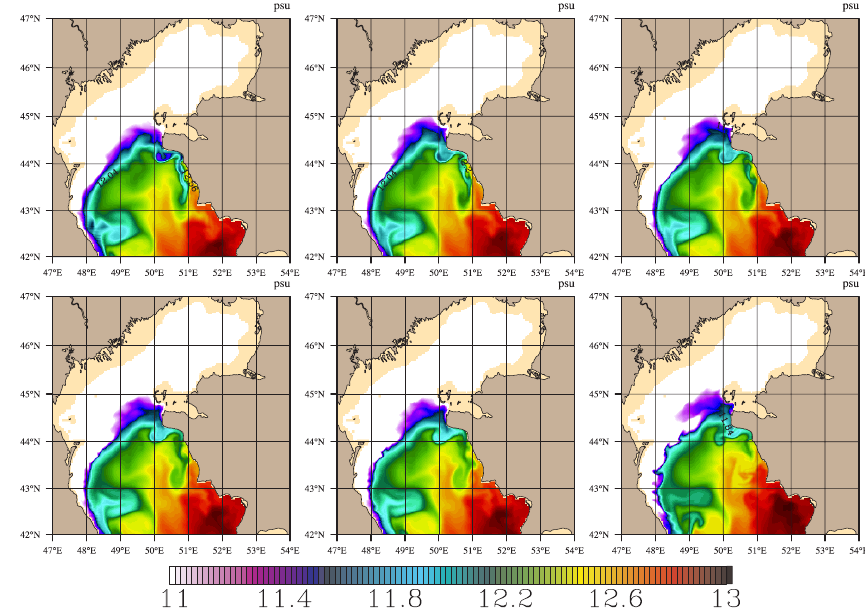
Figure 6. Sea surface salinity (SSS) in practical salinity unit (psu) for 28/30/31 July (upper panel) and 1/2/8 August (lower